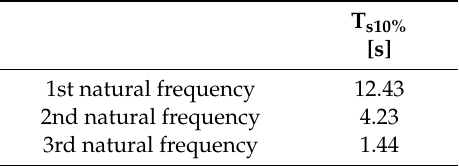
Table 4. Settling times for the unloaded air wing spar.